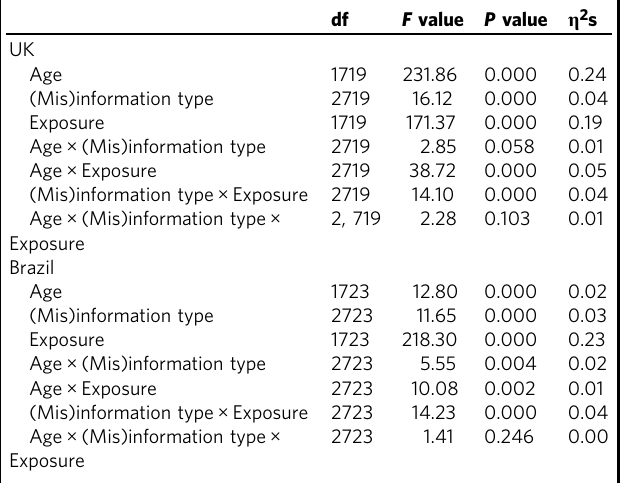
Table 2 Main and interaction effects of age, (mis) information type, and exposure on perceived credibility.